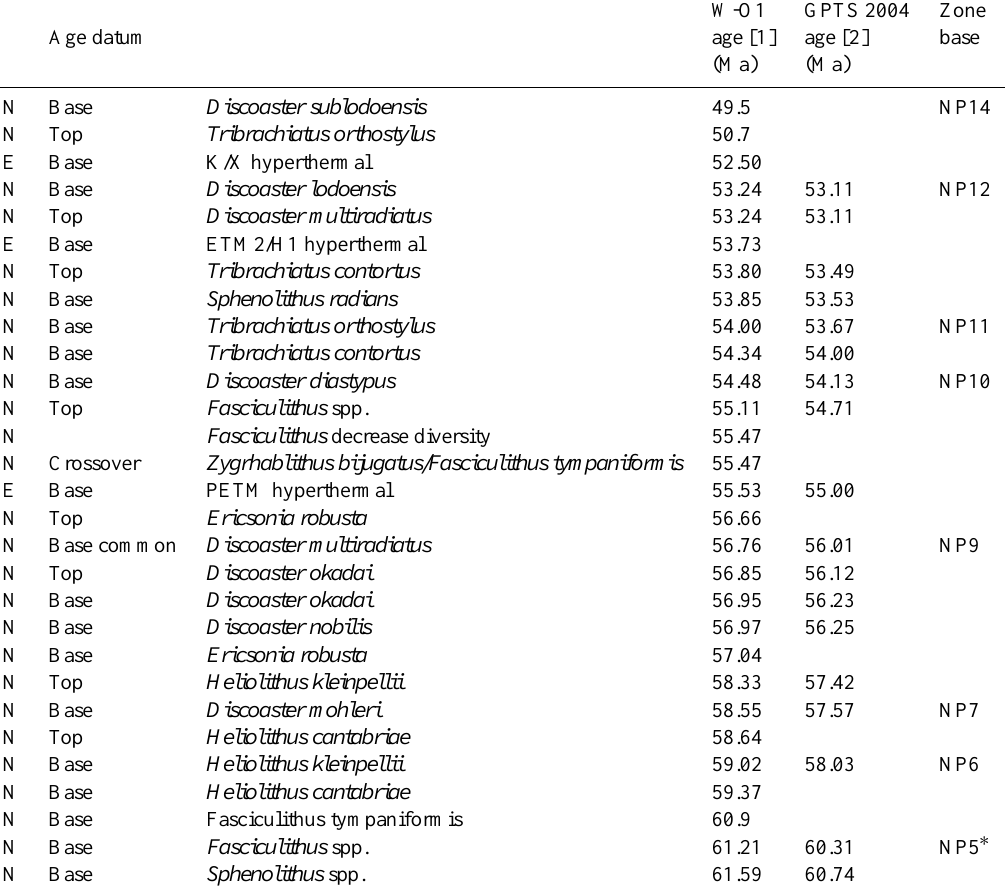
Table 1. Paleomagnetic and nannofossil age estimates for the Paleocene and early